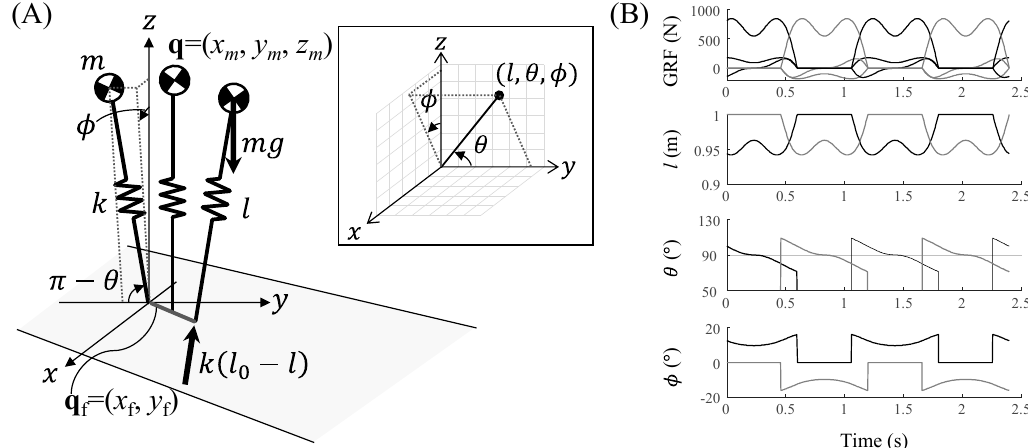
Figure 2. 3D compliant walking model with a point foot control. ( A ) Model parameters and state parameters of the model and spherical coordinates with the y -axis as the zenith (in the inlet). The position of the CoM in 3D; x m , y m , and z m are the positions of the ML, AP, and vertical axes, respectively, and the model state variables l , θ , and φ are the spring length, the angle of the leg respect to the y -axis, and the angle of the projective leg to the z – x plane respect to the z -axis, respectively. ( B ) Example of the GRFs and the state variables during walking. The black and gray lines represent the variables for each leg, respectively. The θ s and φ s for walking solutions range from 68° to 112° and +/ − 17°, respectively.